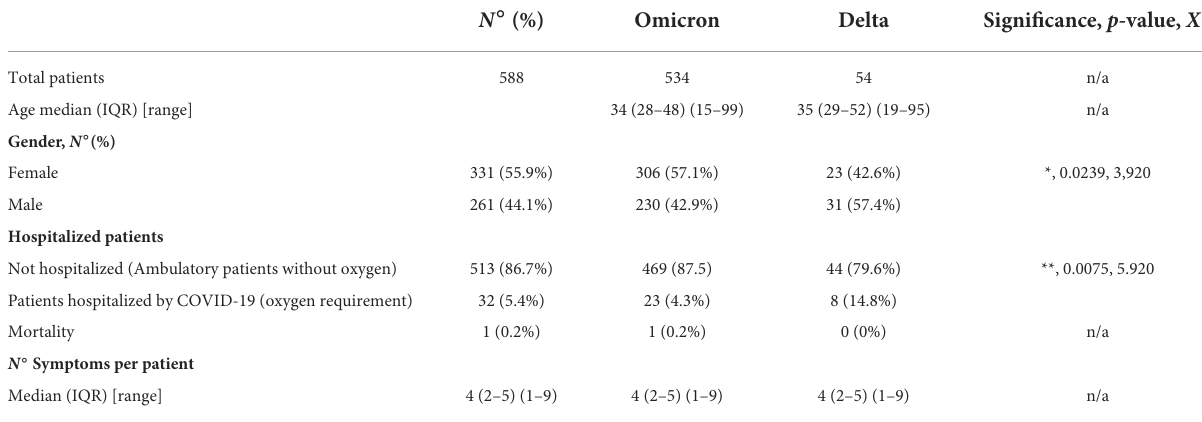
TABLE 1 Epidemiological characteristics of patients infected with the Omicron and Delta variant from a cohort of patients belonging to the Hospital de Urgencia Asistencia Pública (HUAP), Santiago, Chile. N ◦ (%) Omicron Delta Significance, p -value, X 2